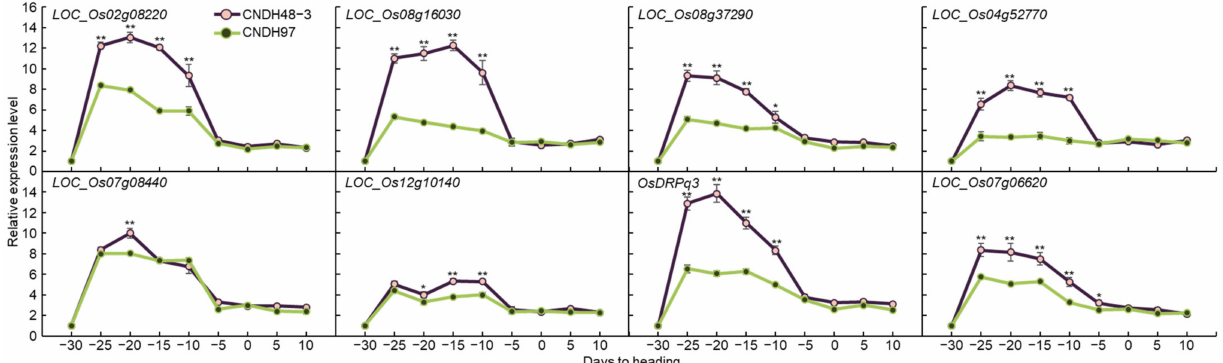
Figure 5. Comparison of relative expression levels of associate genes related to awn development and yield according to the development stage for awn. The associate genes detected by QTL mapping to the relative expression levels were compared. CNDH48-3 is a population with a long awn and low yield. CNDH97 is a population with a high yield and without awn elongation. All associate genes were expressed at higher levels in CNDH48-3 than in CNDH97. However, OsDRPq3 had the most difference in expression levels between CNDH48-3 and CNDH97. Therefore, OsDRPq3 was finally selected. * Significant at the 0.05 level; ** significant at the 0.01